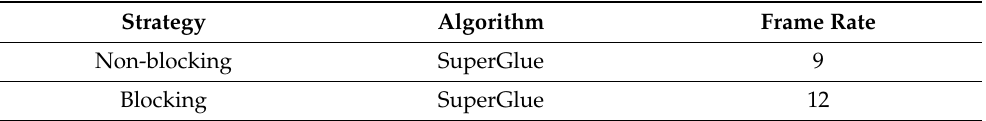
Table 2. Real-time performance of the algorithms.